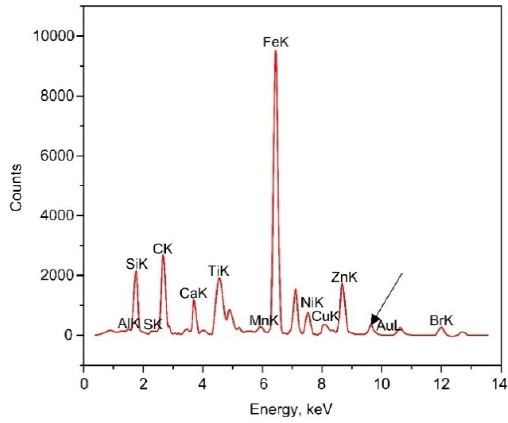
Figure 5. Fluorescence spectrum of the raw material fraction [A].